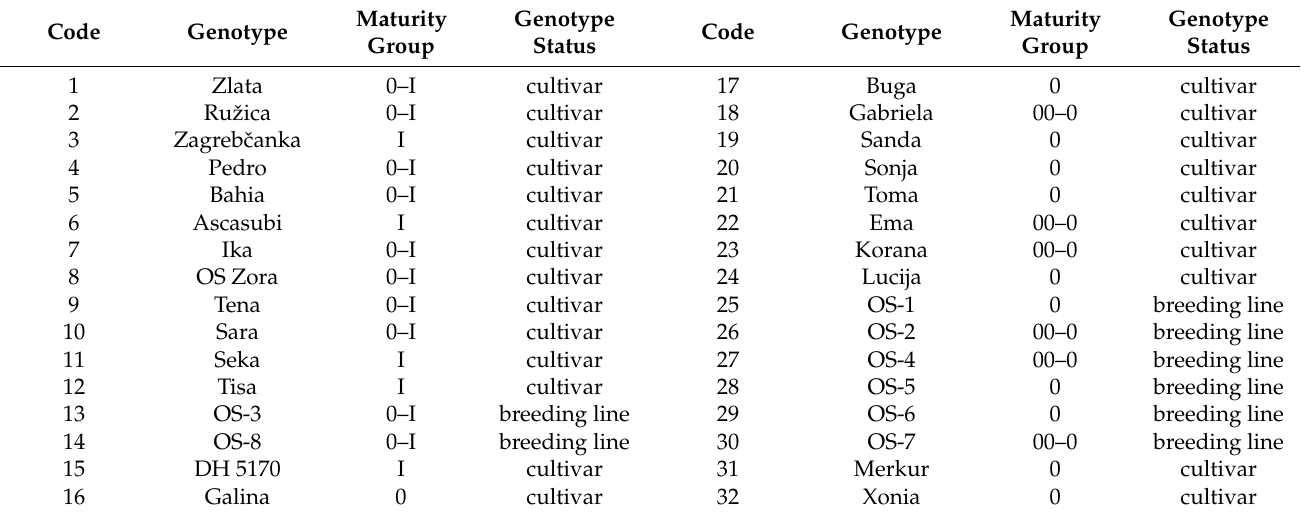
Table 1. List of soybean genotypes used in field experiments and lab